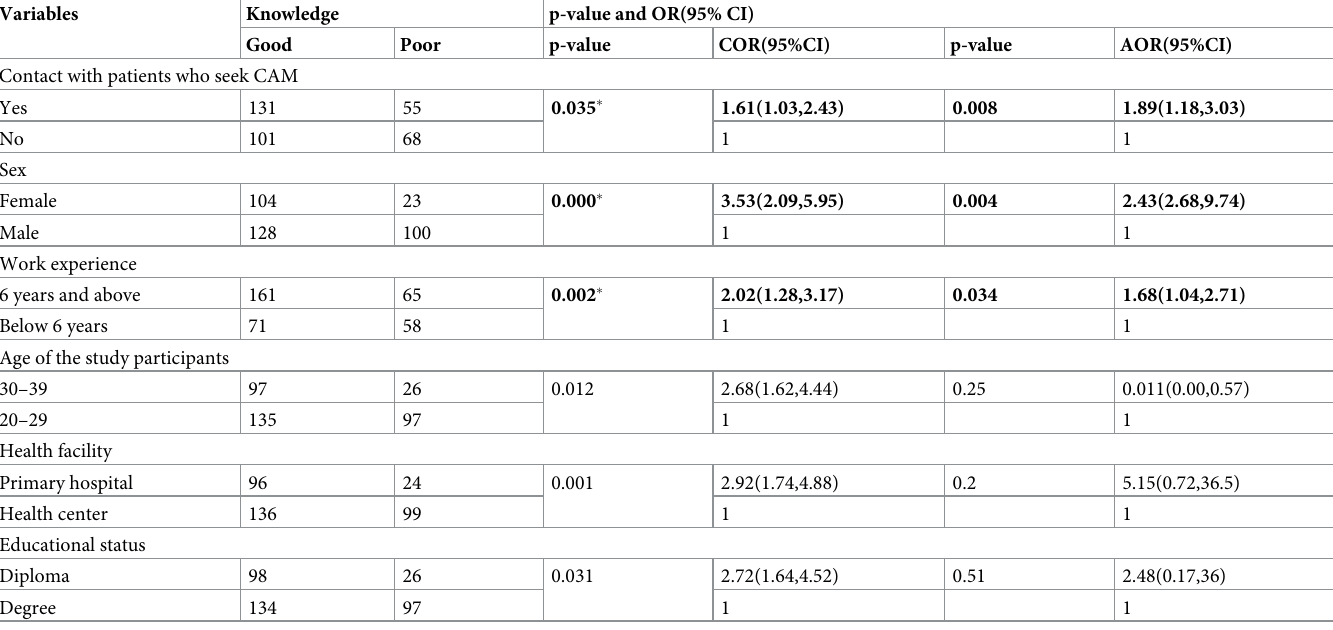
Table 3. Bivariate and multivariable analysis of factors associated with knowledge towards complementary and alternative medicine among health care profession- als in selected primary health care unit in Hadiya Zone, Southern Ethiopia, April, 2021 (n = 355).